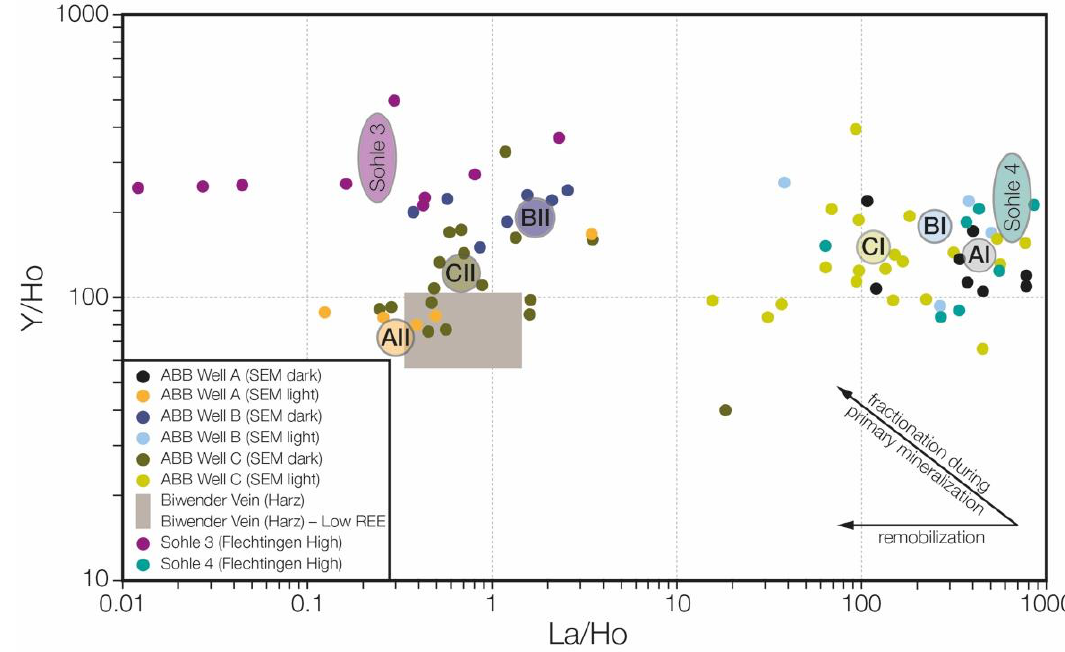
Figure 10. La/Ho versus Y/Ho plot for a selection of fluorite samples from the ABB and the Flechtingen High. The grouping and colours correspond to those in Figure 5 . See text for discussion.